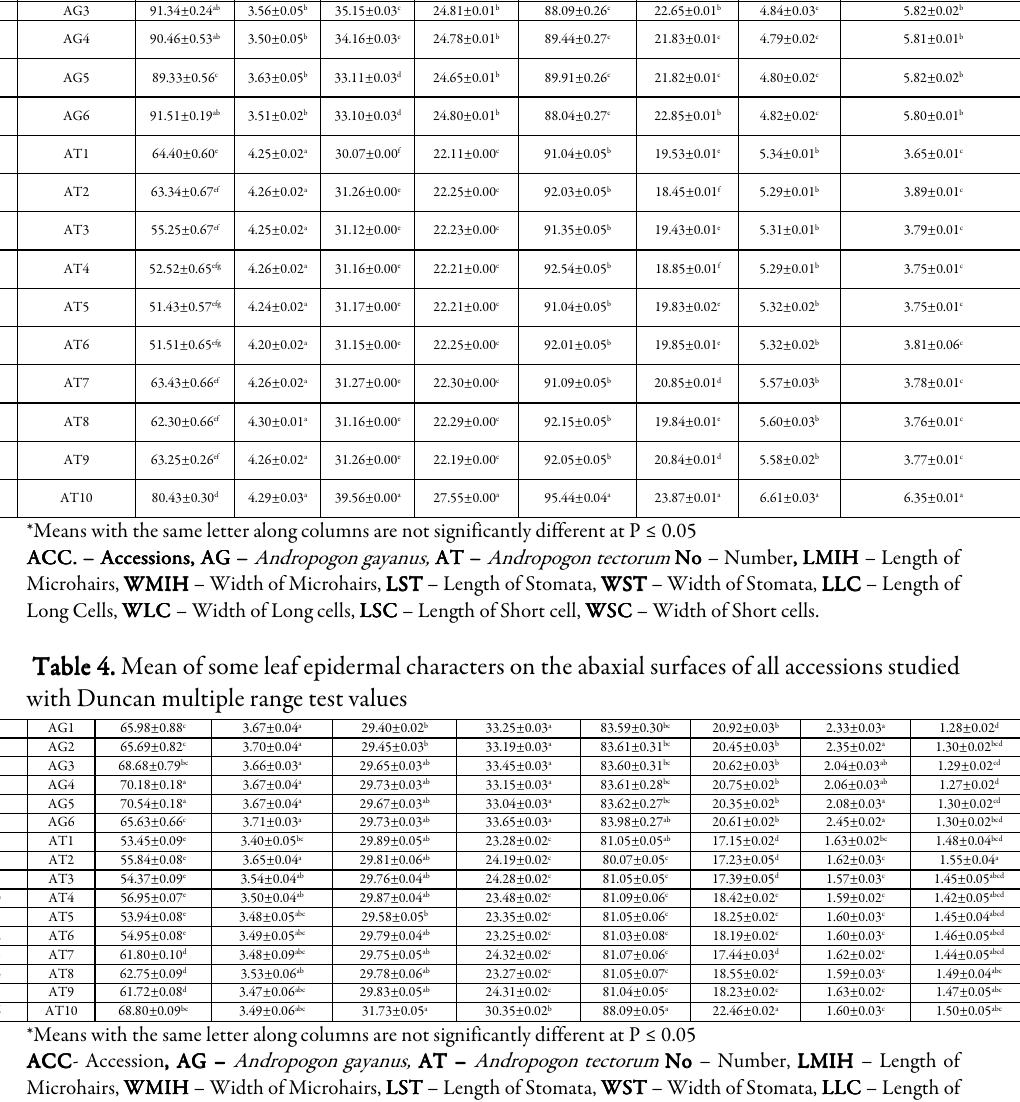
Table 3. Mean of some leaf epidermal characters on the adaxial surfaces of all the accessions studied with Duncan multiple range test values